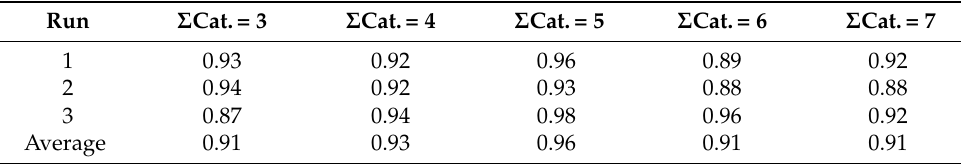
Figure 4. Predicted versus actual activity with time for each sensor type. Classification accuracy was evaluated using three cross-validation folds. The results at each cross-validation run is tabulated in Table 3. An average accuracy and confidence level are computed. The accuracies presented in Section 4 are the averaged results. Table 3. Accuracy at each cross-validation fold for Acceleration